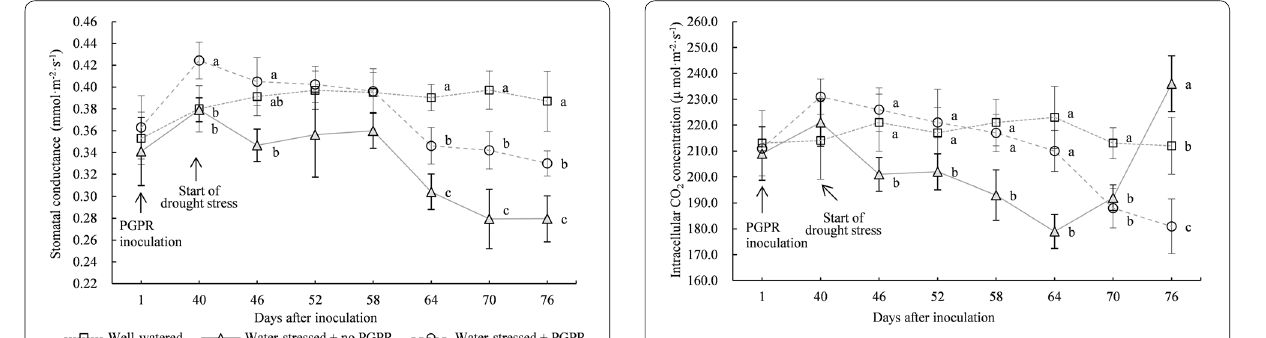
Fig. 3 Effects of Acinetobacter calcoaceticus X128 inoculation on the intracellular CO 2 concentrations of Sambucus williamsii Hance container seedlings under drought-stressed condition. Values are means of three repeating groups (twelve seedlings for each repeat group). Bars represent the standard deviation. Different letters indicate significant differences for the intracellular CO 2 concentrations on the same day after inoculation at P < 0.05 by